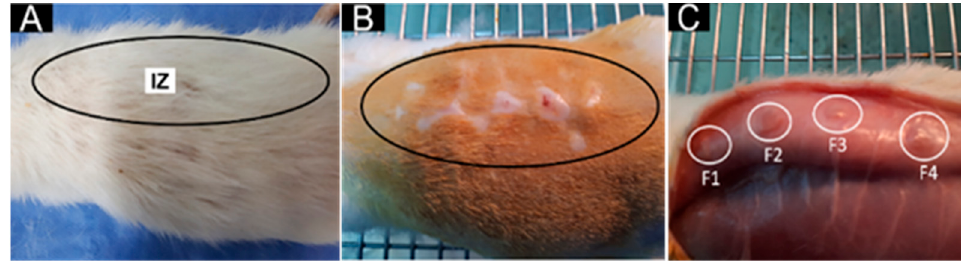
Figure 10. Subdermal dorsal section implanted in biomodel. ( A ): Dorsal area with hair. ( B ): Dorsal area with a trichotomy. ( C ): The internal area of the skin. Black ovals and IZ: implantation zone. White circles: individual implantation zones.